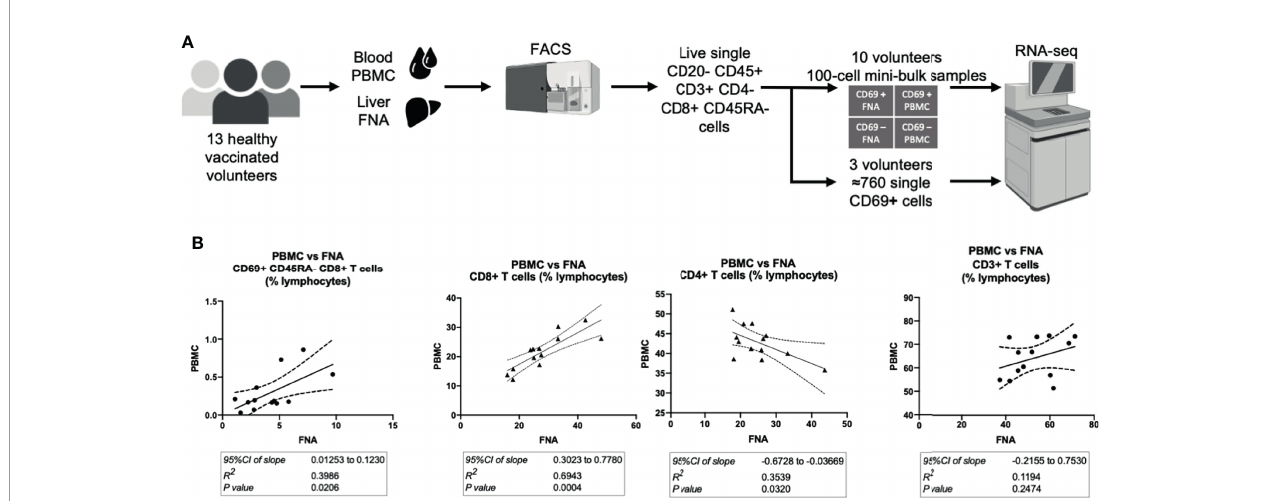
FIGURE 1 | Hepatic and circulating lymphocytes correlate numerically and phenotypically when analysed by fl ow cytometry. (A) Sampling work fl ow. 15 volunteers across all vaccination groups were recruited for liver FNA sampling. Two volunteers were unable to provide samples, due to logistical reasons, and withdrew on the sampling days. Hepatic fi ne needle aspirate and peripheral venesection were performed within one hour. Lymphocytes were isolated, stained for fl ow cytometry/cell sorting and sorted within three hours of sampling. Ten volunteers ’ FNA and PBMC samples were two-way sorted for 100-cell mini-bulk RNA-sequencing and three volunteer samples were sorted for single-cell RNA-sequencing. (B) Quantitative correlations between liver and blood samples. The 95%CI of linear regression slope, R2 value of goodness of fi t and the p value that the slope is signi fi cantly non-zero are presented below the respective plots. The P values were calculated by F tests. All plots are derived from 13 matched FNA and PBMC samples. All values are presented as a proportion of single CD45+ lymphocytes in each sample. CI, con fi dence interval. FNA, fi ne needle aspirate. GMFI, geometric mean fl uorescence intensity. PBMC, peripheral blood mononuclear cells. tSNE, t-distributed stochastic neighbour